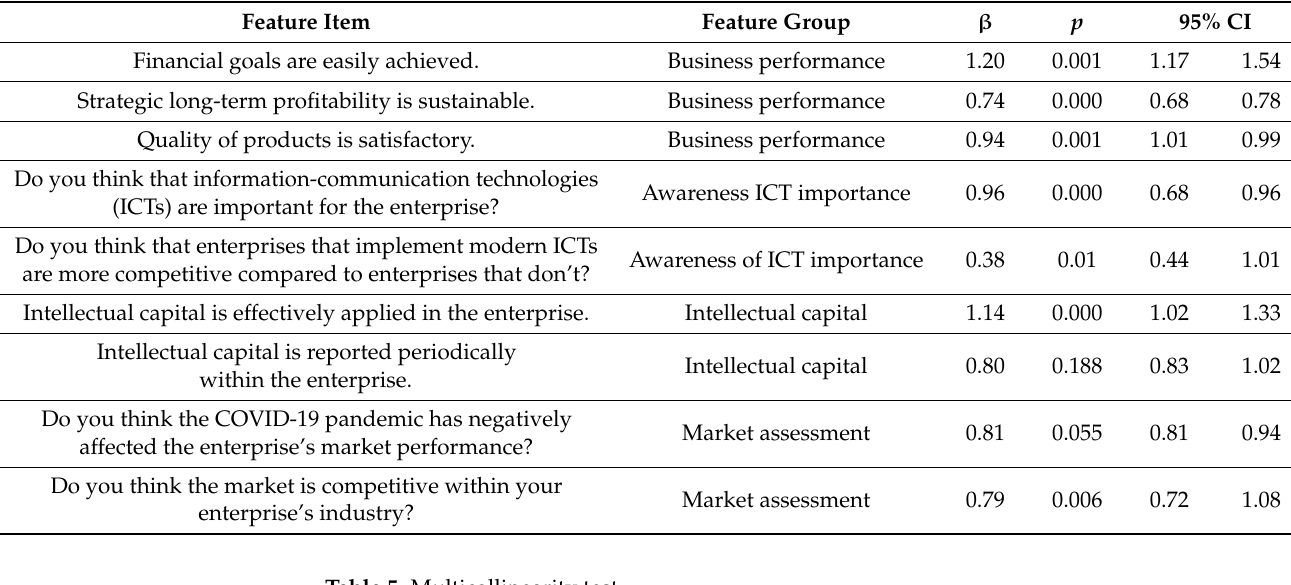
Table 5. Multicollinearity test.